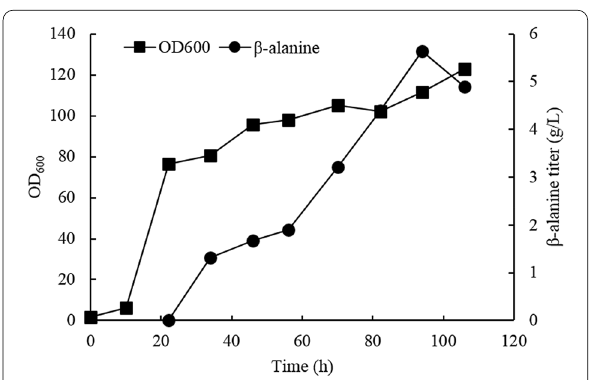
Fig. 7 Fed-batch fermentation profile of 2ADC-Spe strain